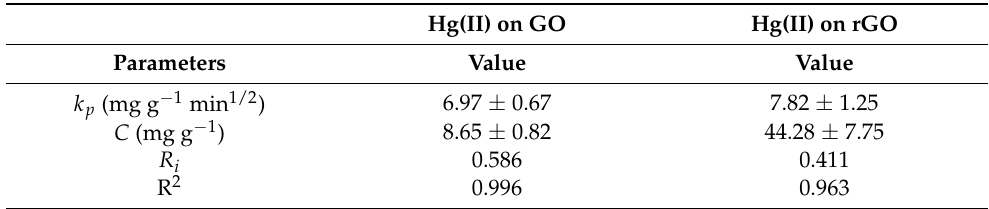
Table 3. Estimated parameters of the intraparticle diffusion (IPD) model at 298 K for the adsorption of Hg(II) on GO and